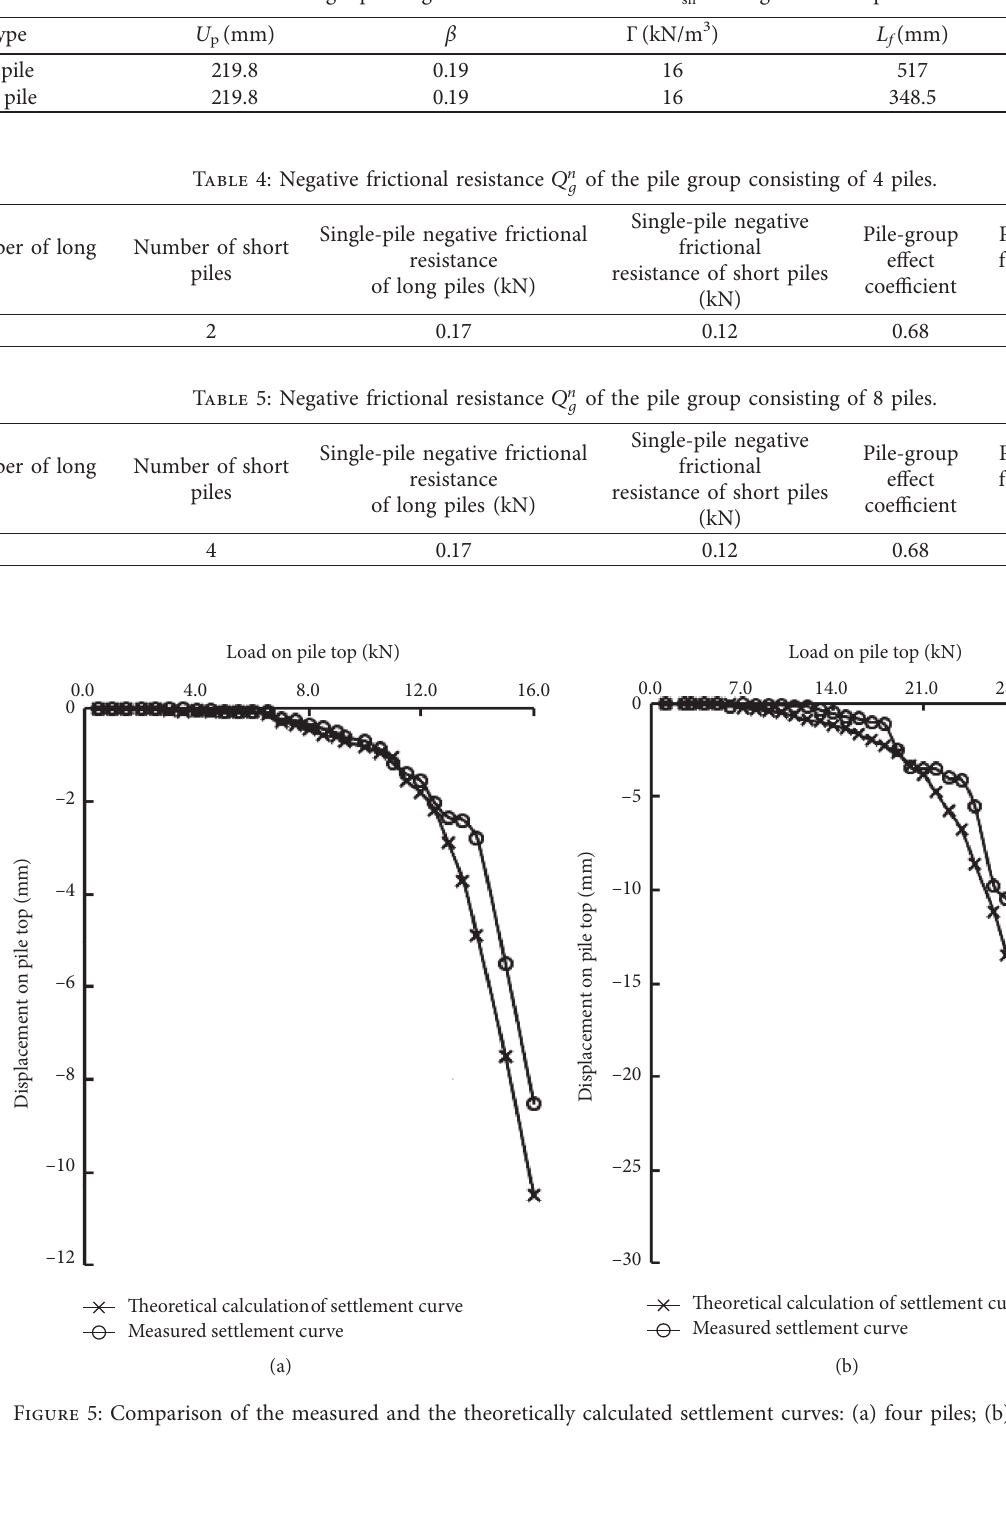
Table 3: Single-pile negative frictional resistance P